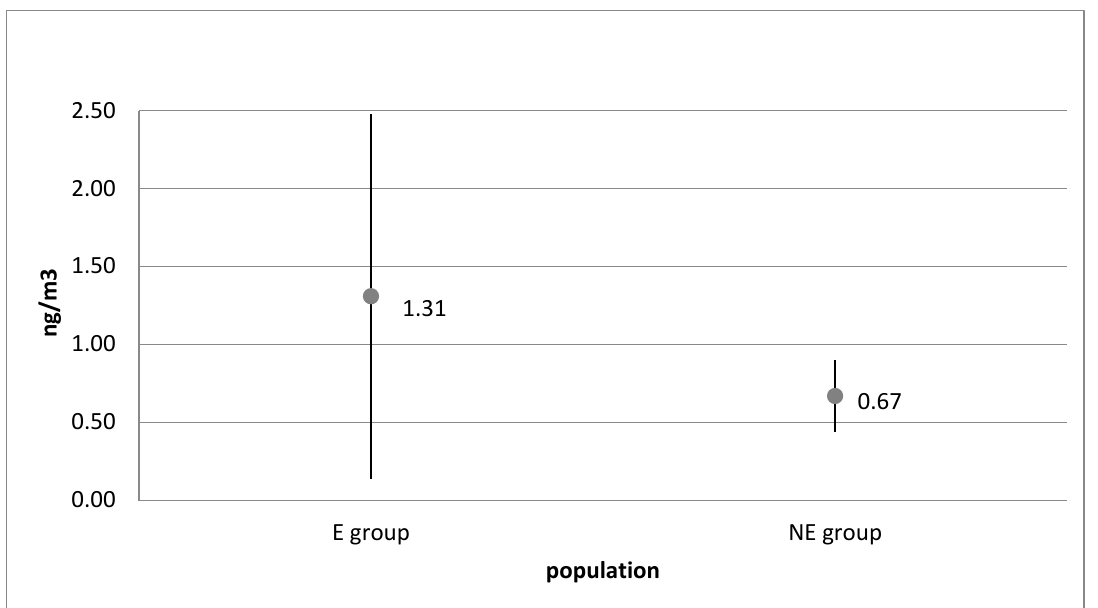
Figure 2. Residential background PM 2.5 concentration average and standard deviation. E vs. NE (μg/m 3 ).